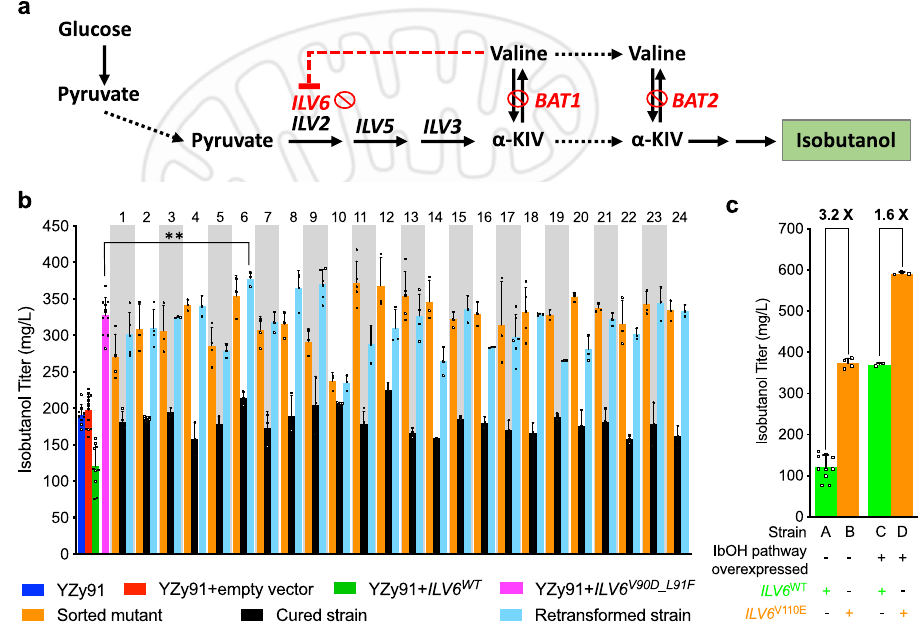
Fig. 3 High-throughput screen for metabolically hyperactive Ilv6p mutants using the biosensor in its isobutanol con fi guration. a Schematic representation of the genotype of the basal strain, YZy91, used for high-throughput screening of Ilv6p mutants with enhanced activity in the presence of valine; α -KIV: α -ketoisovalerate. Mitochondrion image created with BioRender. b Isobutanol titers after 48 h fermentations of sorted strains with unique ILV6 mutant sequences (orange), plasmid-cured derivatives (black), and strains obtained from retransforming YZy91 with each unique plasmid isolated from the corresponding sorted strain (cyan). Titers obtained from YZy91 with (red) or without (blue) an empty vector, or transformed with plasmids containing ILV6 WT (green) or ILV6 V90D_L91F (magenta), are shown as controls. The numbers on the upper x-axis identify each of the strains harboring screened mutants with unique ILV6 sequences. ILV6 mutants 1 – 10 were isolated from the sorted wild-type ILV6 ( ILV6 WT ) mutagenesis library. ILV6 mutants 11 – 24 were isolated from the sorted ILV6 V90D_L91F mutagenesis library. A two-sided t -test was used to determine the statistical signi fi cance of the difference in isobutanol titers between YZy91 with ILV6 V90D_L91F (magenta) and ILV6 V110E ( ILV6 mutant #6). P = 0.0055; ** P ≤ 0.01. c Isobutanol titers of YZy91 transformed with CEN plasmids containing ILV6 WT (Strain A) or ILV6 V110E ( ILV6 mutant #6, Strain B) compared to titers from a strain overexpressing the mitochondrial isobutanol pathway (YZy363) transformed with CEN plasmids containing ILV6 WT (Strain C) or ILV6 V110E ( ILV6 mutant #6, Strain D). All data are shown as mean values. Open circles represent individual data points. Error bars represent the standard deviation of at least three biological replicates. Source data are provided as a Source Data fi